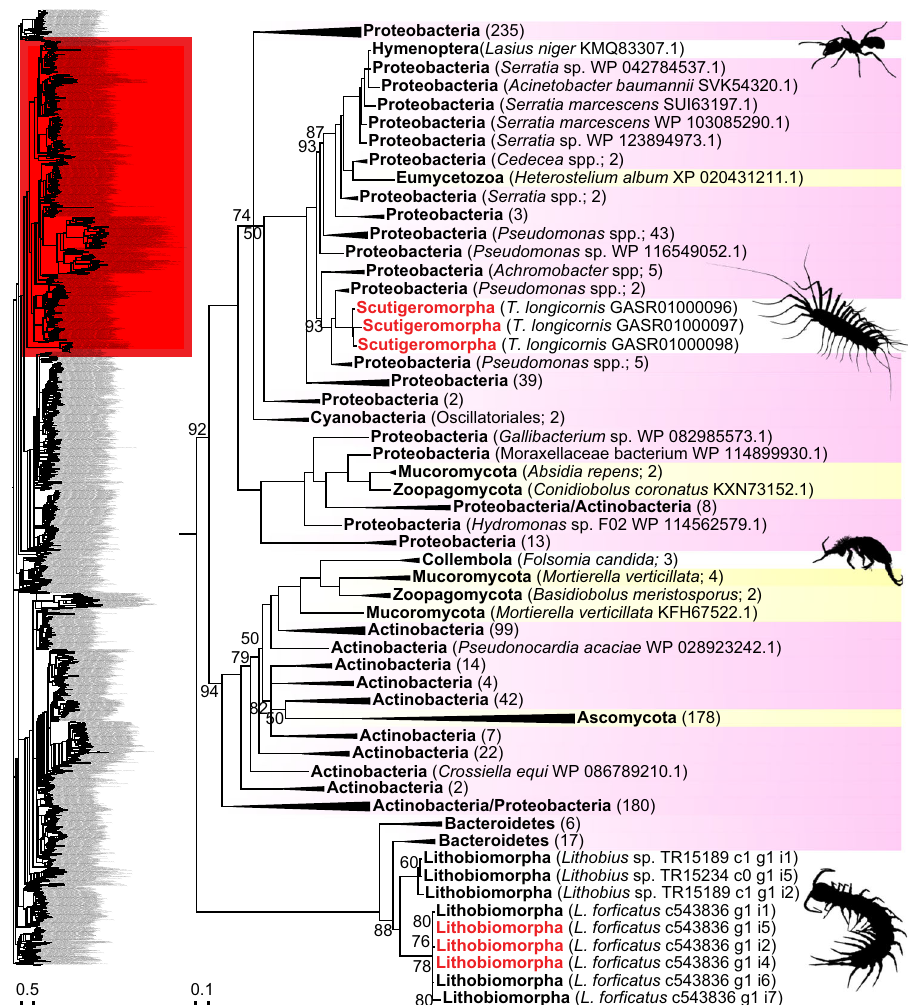
Fig. 3 A maximum likelihood tree of PAD sequences shows two clades of centiPAD sequences nested within a paraphyletic backbone of bacterial sequences. The tree represents one clade nested within a larger tree (red highlight in inset) made up entirely of bacterial sequences. The tree shows that centiPADs originated from two bacterial HGTs, one within the lithobiomorph lineage, and one within the scutigeromorph lineage. Centipede sequences are in black (present in transcriptomes) and red (present in transcriptomes and venom proteomes). Highlighted sequences are Bacteria (pink) and Fungi (yellow). Metazoan sequences are not highlighted. Collapsed clades have the number of included sequences indicated in parentheses. For the uncollapsed tree see Supplementary Fig. 3. The tree was reconstructed using the WAG + G4 model and is displayed as midpoint rooted. Bootstrap support values are shown for each clade, and clades with support <50% are collapsed into polytomies. Clades without bootstrap values have >95% support. Collembolan image was sourced from Phylopic (www.phylopic.org; credit for the Collembola image is with Birgit Lang: falls outside the 99th percentile (0.557) of all non-HGT centipede